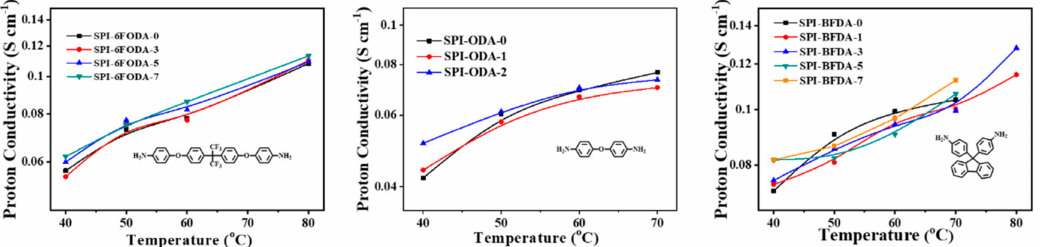
Figure 9. Proton conductivity of the three SPI based